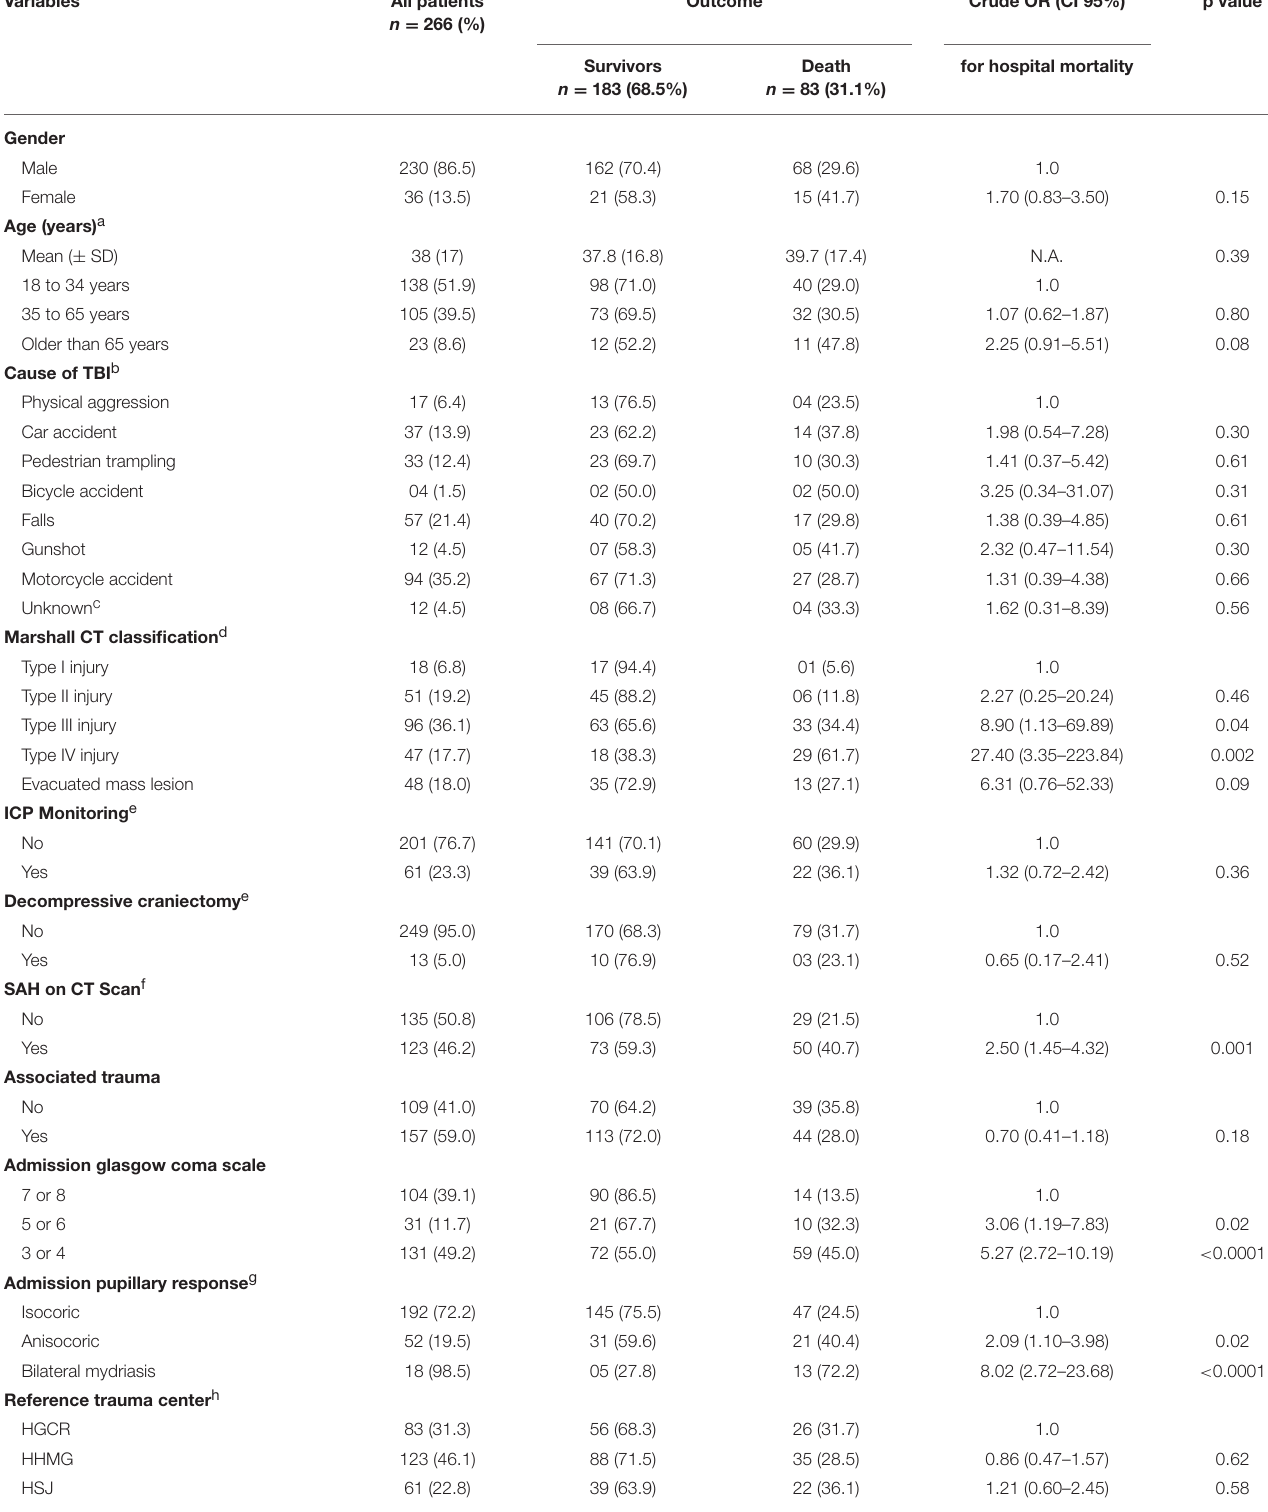
TABLE 1 | Distribution of clinical, demographic, radiological, and neurosurgical variables of patients admitted with severe traumatic brain injury according to the hospital mortality. Variables All patients